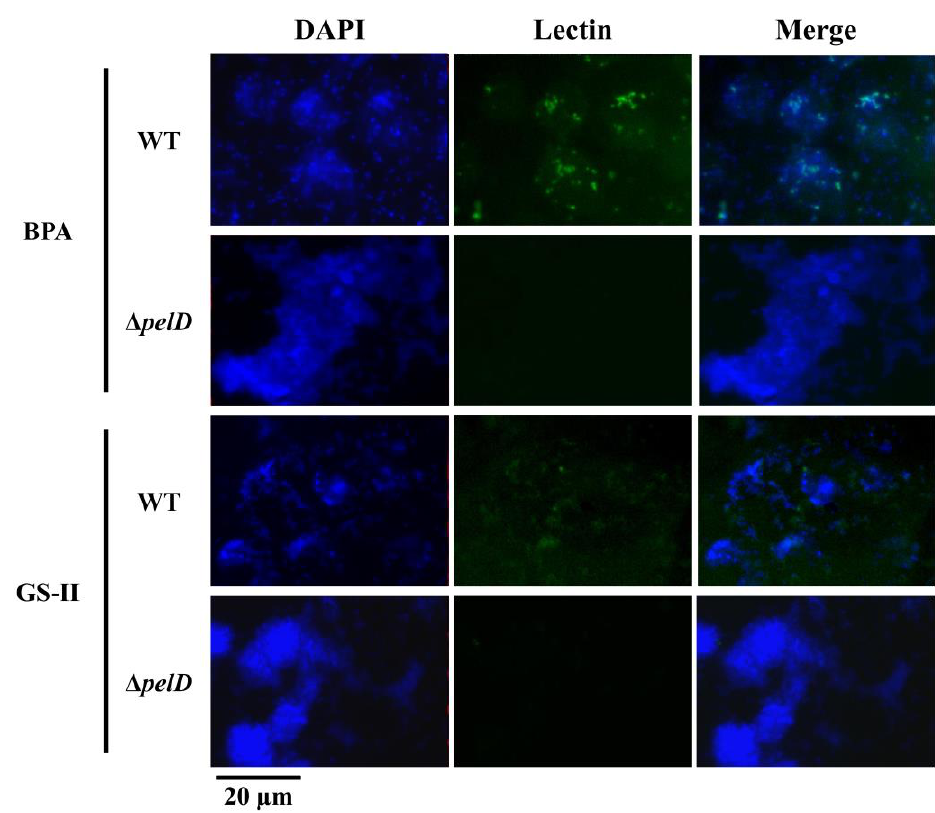
Figure 1. Analysis of PEL exopolysaccharide composition by using epifluorescence microscopy coupled to FLBA. S ◦ -coupons colonized by A. thiooxidans T (WT) or mutant derived ( ∆ pelD ) cells were extracted from 5-days growth cultures and incubated with FITC-conjugated BPA or GS-II lectins. Then, they were stained with DAPI before microscopy imaging. Size bars represent 20 µm.